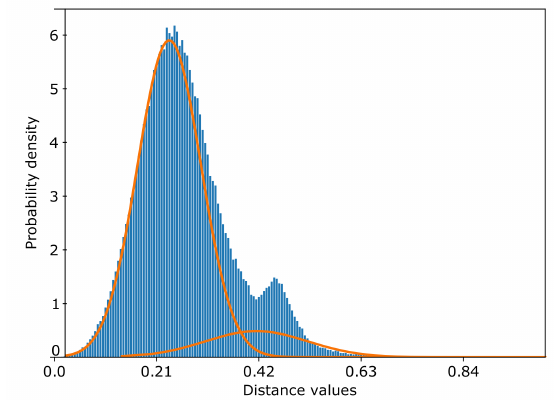
Figure 6. Histogram over maximum matrix profile values d max and a mixture of two Gaussian distributions fitted to these values. The first Gaussian corresponds to pixels from the unchanged regions, whereas the second one corresponds to pixels from regions affected by anomalous